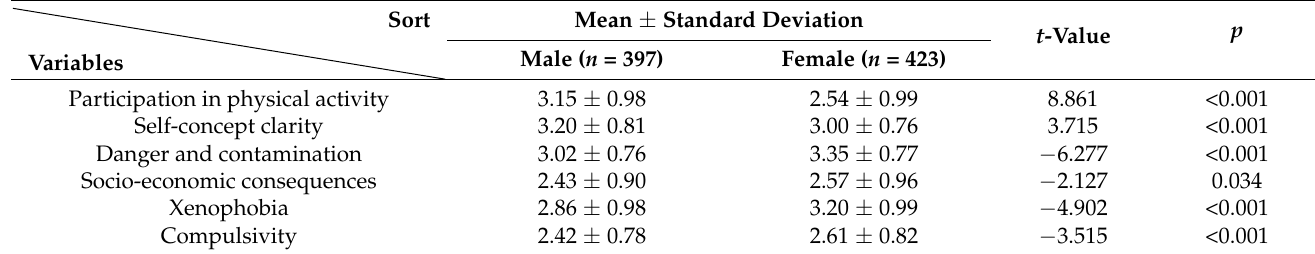
Table 7. Gender differences in each